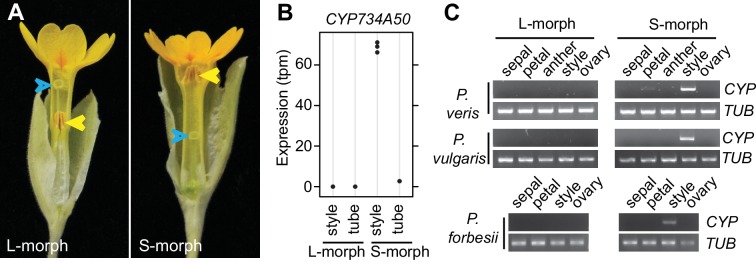
Identification of CYP734A50 as an S-morph and style-specific gene.(A) Dissected P. veris L- (left) and S-morph flowers (right), showing reciprocal differences in style length and anther position (yellow arrowheads). Blue arrowheads indicate stigmas on top of styles. (B) Expression levels of CYP734A50 in P. veris based on RNA-seq (n = 3 biological replicates each). See also Figure 1—source data 1. (C) Expression of CYP734A50 and TUBULIN in dissected floral organs. Full gel images and qRT-PCR quantification based on three biological replicates are shown in Figure 1—figure supplement 2 and 3.DOI:
http://dx.doi.org/10.7554/eLife.17956.00310.7554/eLife.17956.004Figure 1—source data 1.Candidates for S-morph style-specific genes.TPM values and annotations are indicated for candidate transcripts showing significantly (p<0.05) higher expression in S-morph styles than in S-morph corolla tubes and in either L-morph styles or corolla tubes.